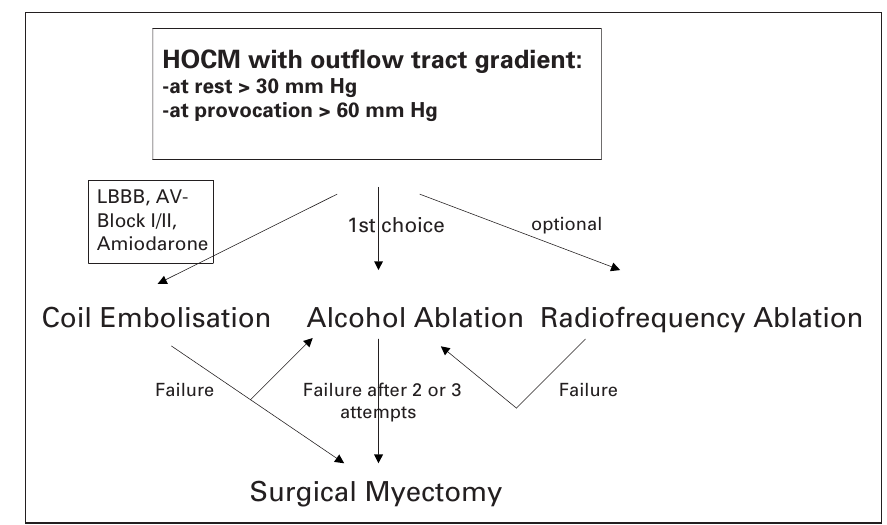
Figure 1 Treatment recommendation in HOCM